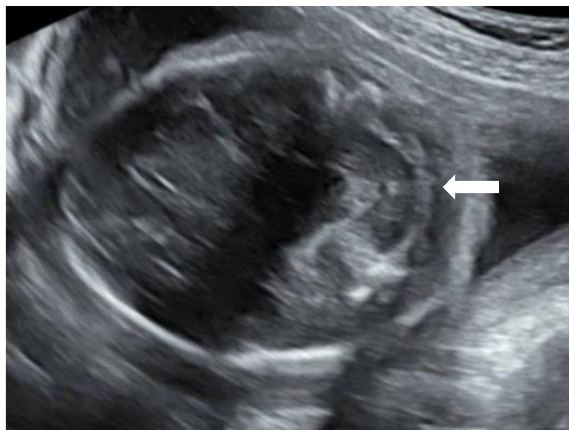
Figure 2. Overt banana-shaped cerebellum at 24 weeks.